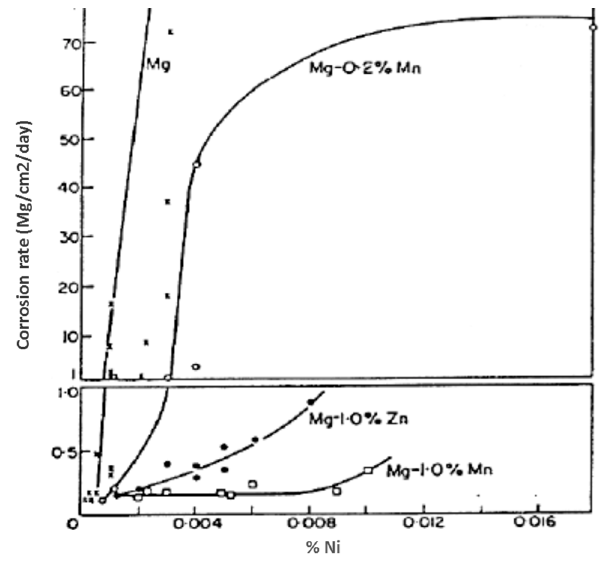
Figure 21. Tolerance limits for Nickel in pure Mg and Mg-Zn and Mg-Mn alloys. Modified from [129].